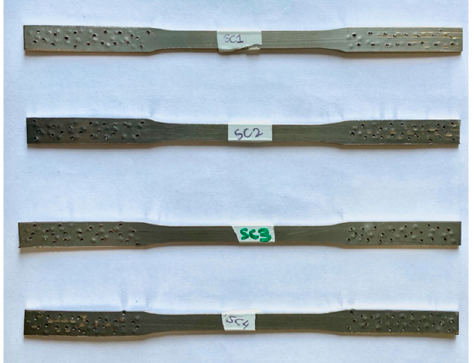
Figure 2. Dog-bone specimens used for the fatigue tests.